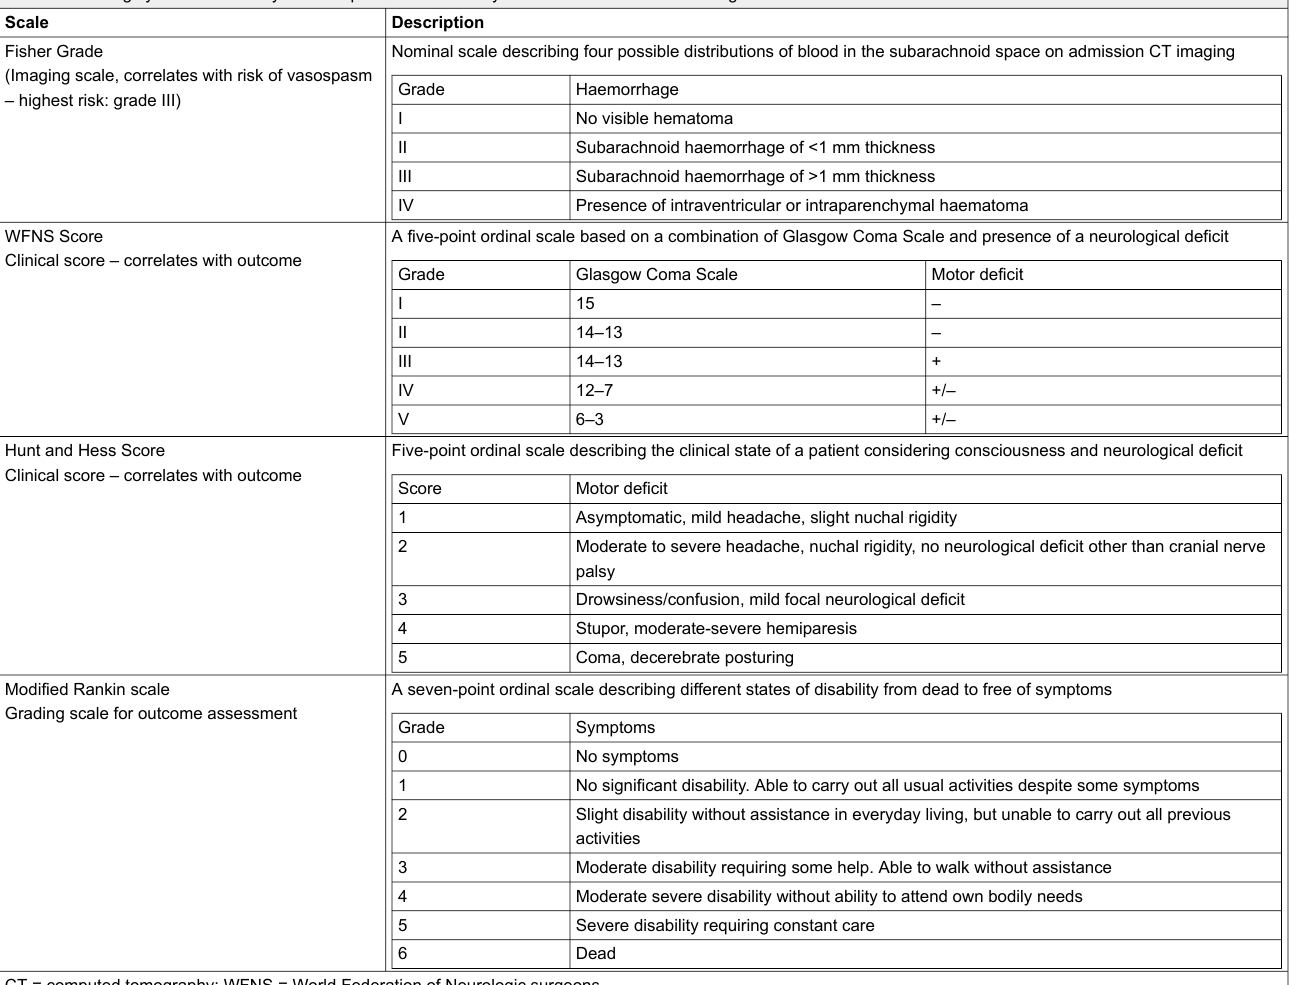
Table 1: Grading systems commonly used for patients with aneurysmal subarachnoid haemorrhage